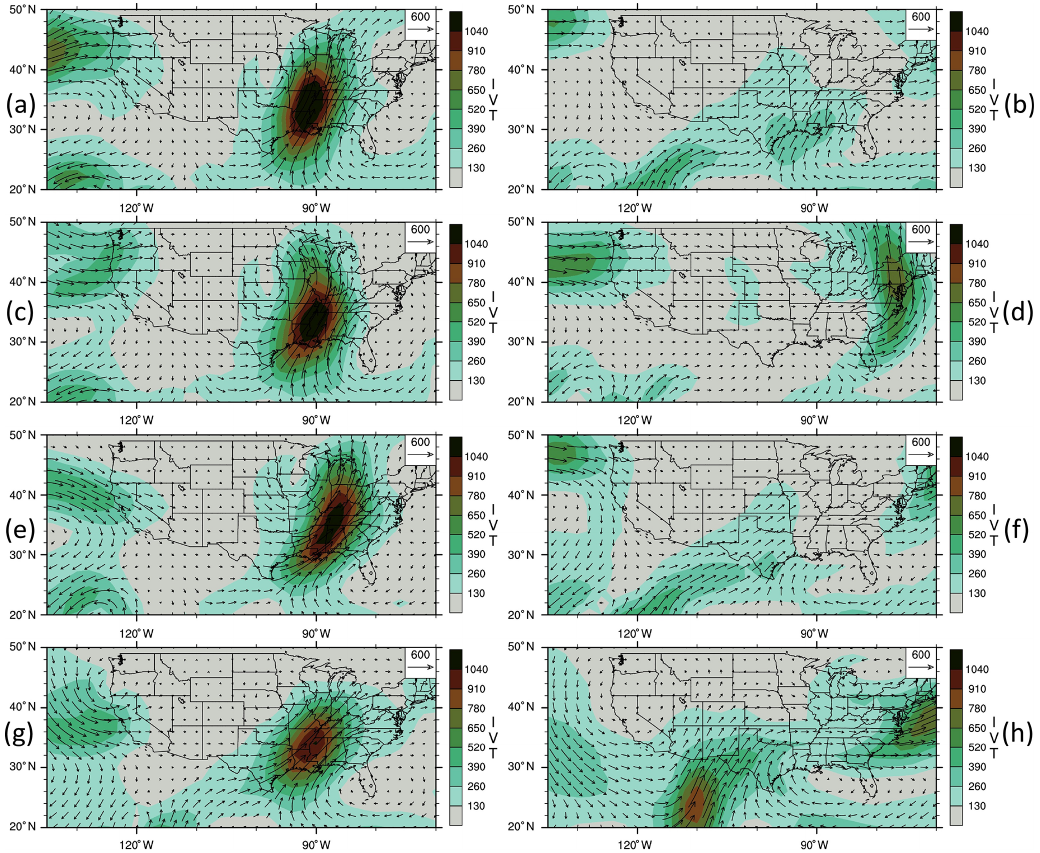
Figure 17. The 200–1000hPa vertically integrated water vapor transport (IVT; kgms − 1 ; contour) and wind vectors (ms − 1 ; arrows) in the day 7 forecasts, validated at 00:00UTC on 27 (a, c, e ) and on 28 (b, d, f) November 2019 for (a, b) BASE, (c, d) AEOM, (e, f) AEOT, and (g, h) ECMWF